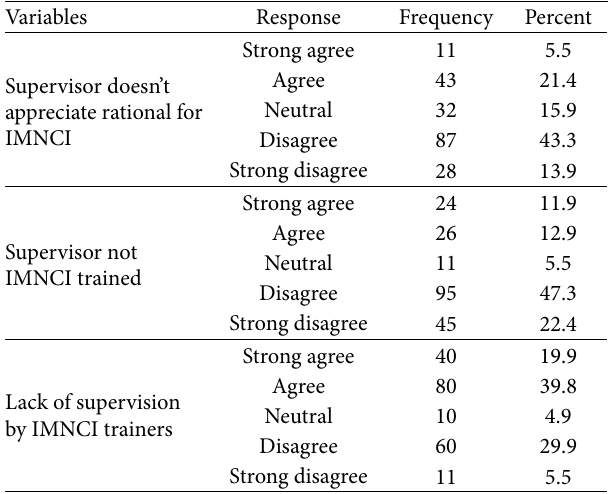
Table 16: Training of